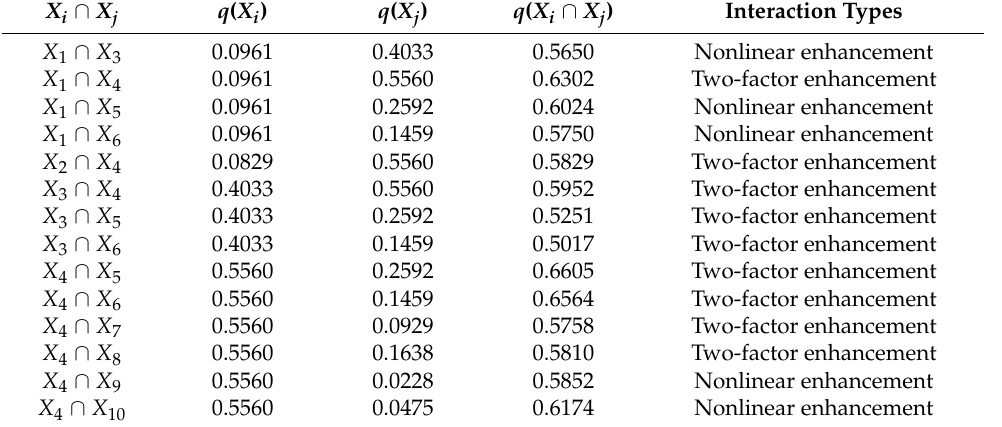
Table 7. The results of Interaction Detector for the spatial heterogeneity of average ESV in the